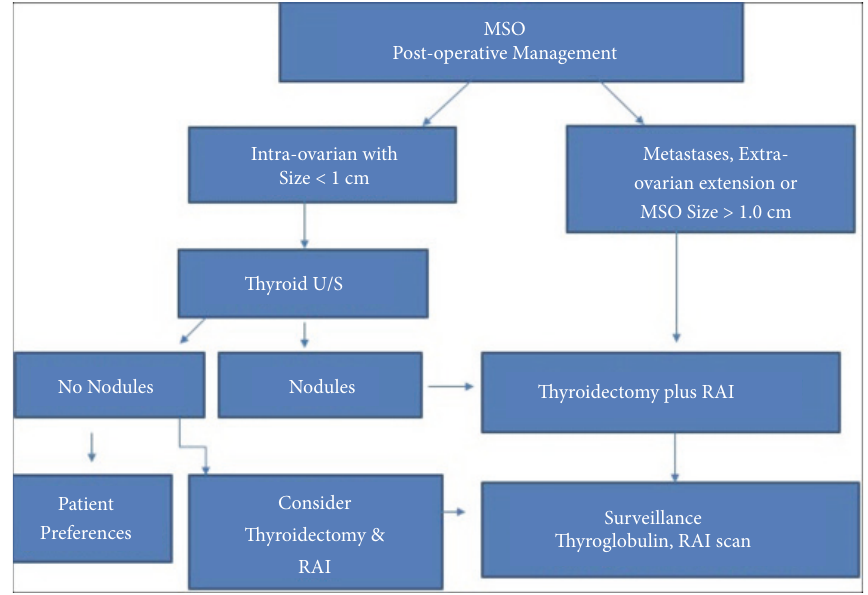
Figure 3: Algorithm summarizing current trends in postoperative management of malignant struma